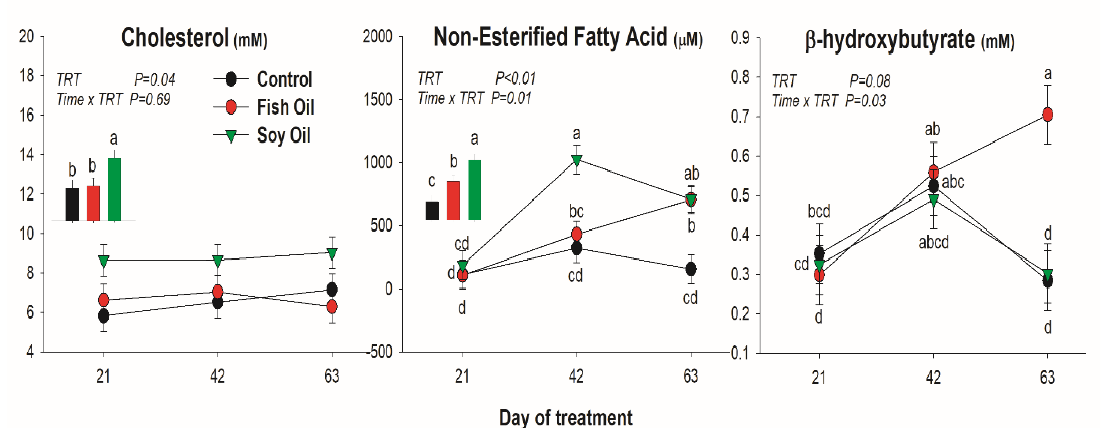
Figure 1. Effect on lipid-related blood metabolites of long-term supplementation of lactating dairy cows (n = 5/group) with soybean oil or fish oil. The p -value of the overall treatment (TRT) and TRT × Time interaction is reported. Data were corrected for the baseline before statistical analysis. Bars denote standard error of the means. Insert bar graph denote the means between treatments.